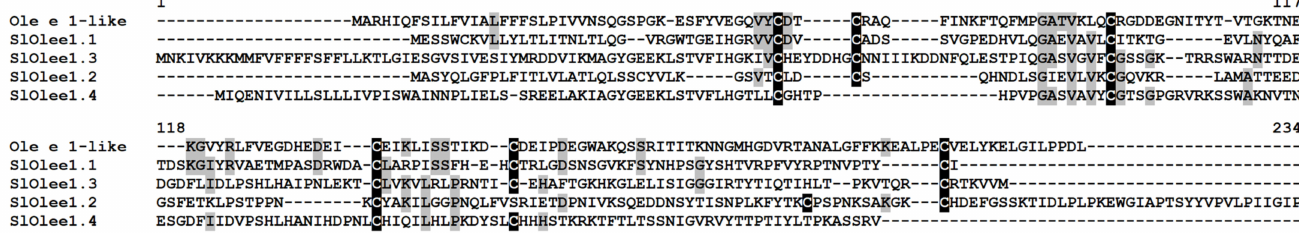
Figure 13. Multiple sequence alignment of S. lycopersicum Ole e 1 precursors and O. europaea Ole e 1-like (XP_022872526.1). Cysteine residues are shaded black, and identical amino acids are shaded